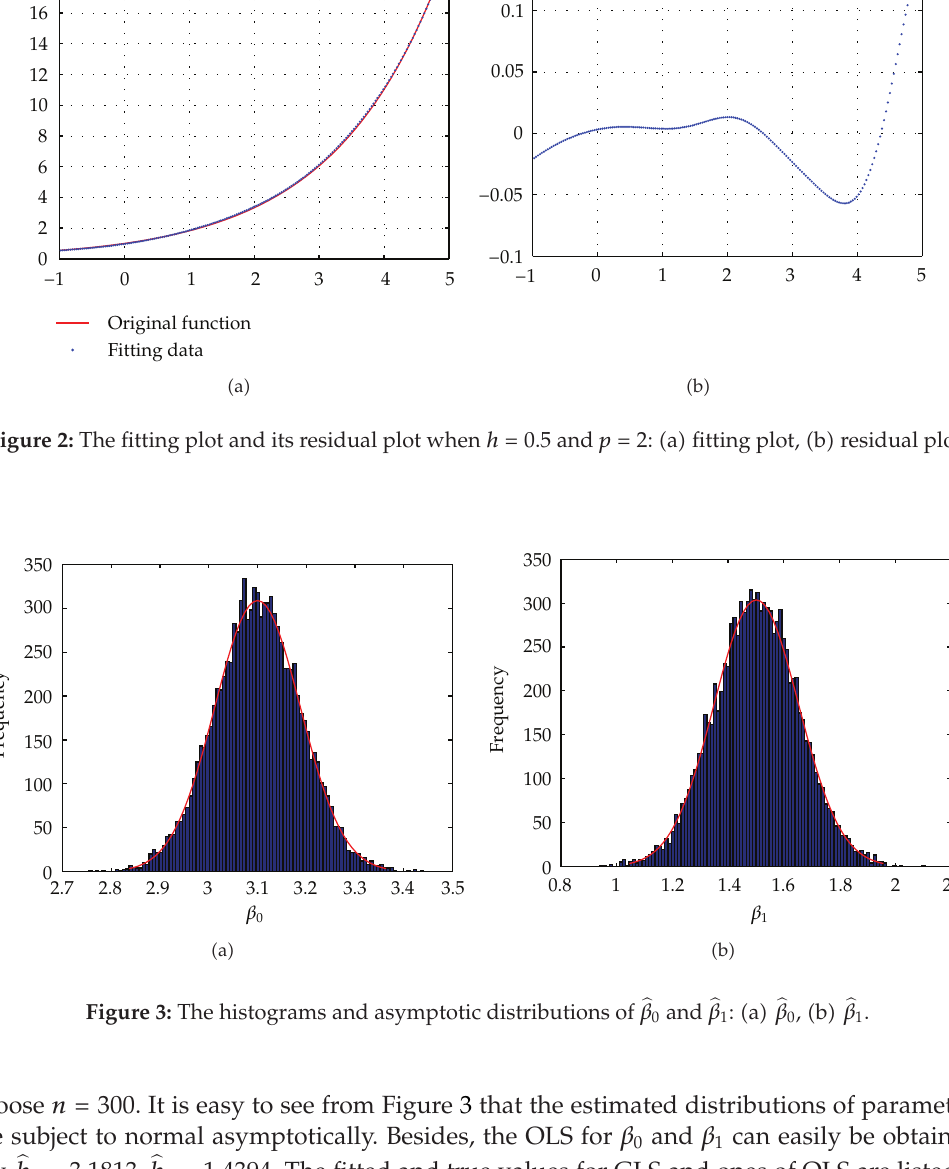
Figure 3: The histograms and asymptotic distributions of